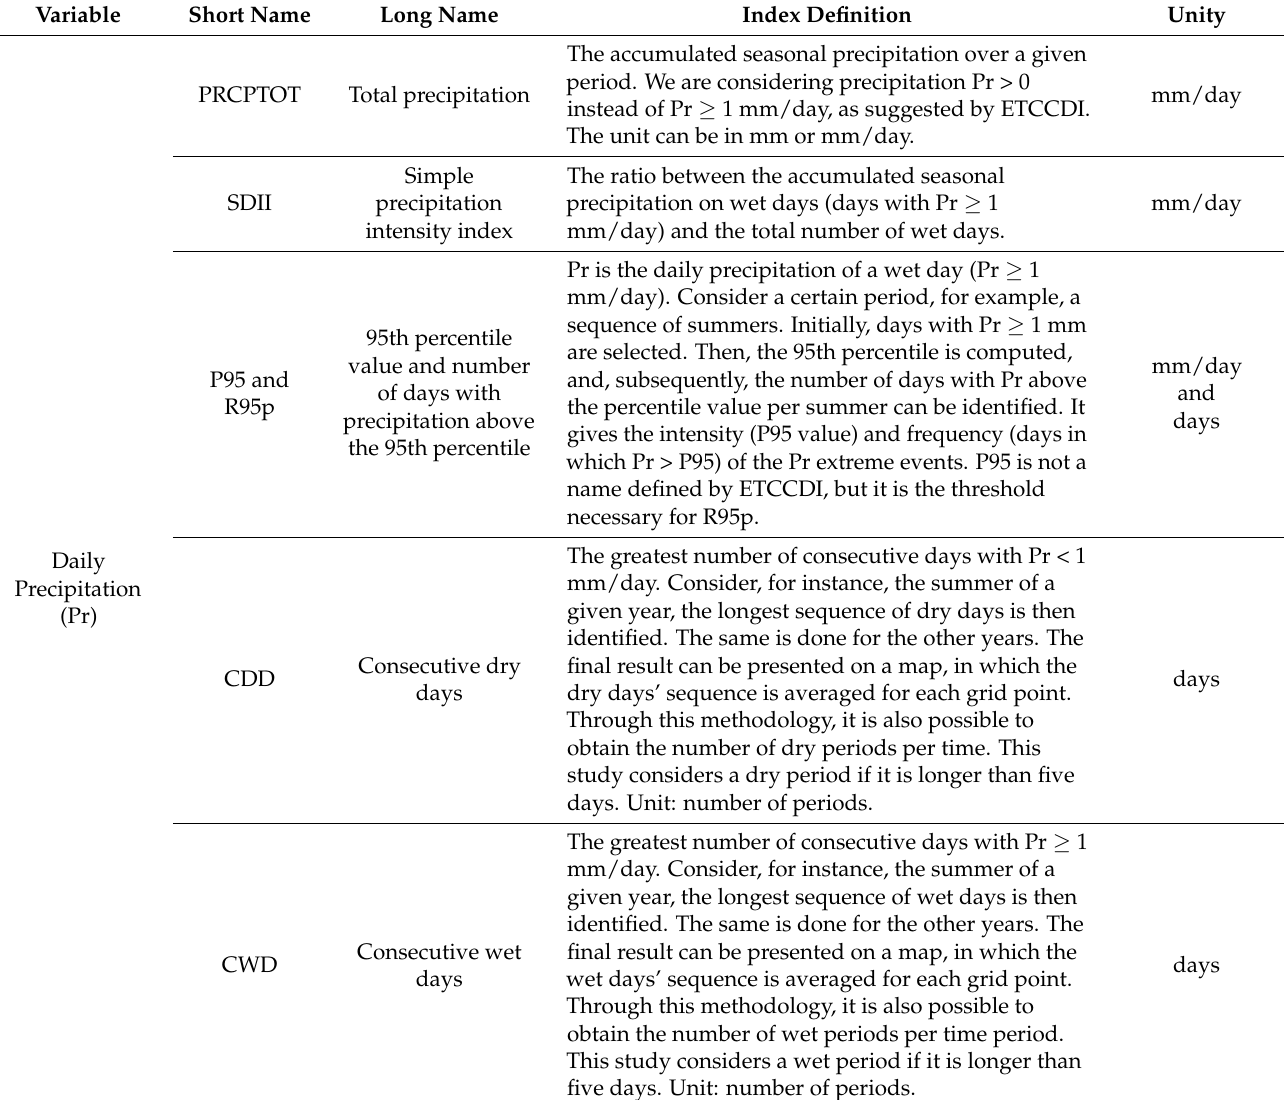
Table 2. Description of climate indices calculated in this